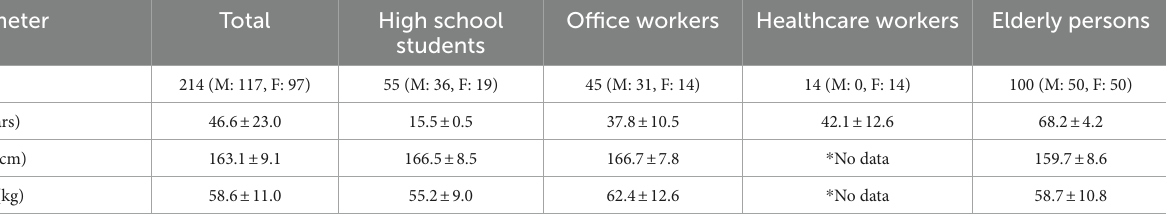
TABLE 1 Participants’ demographic characteristics.